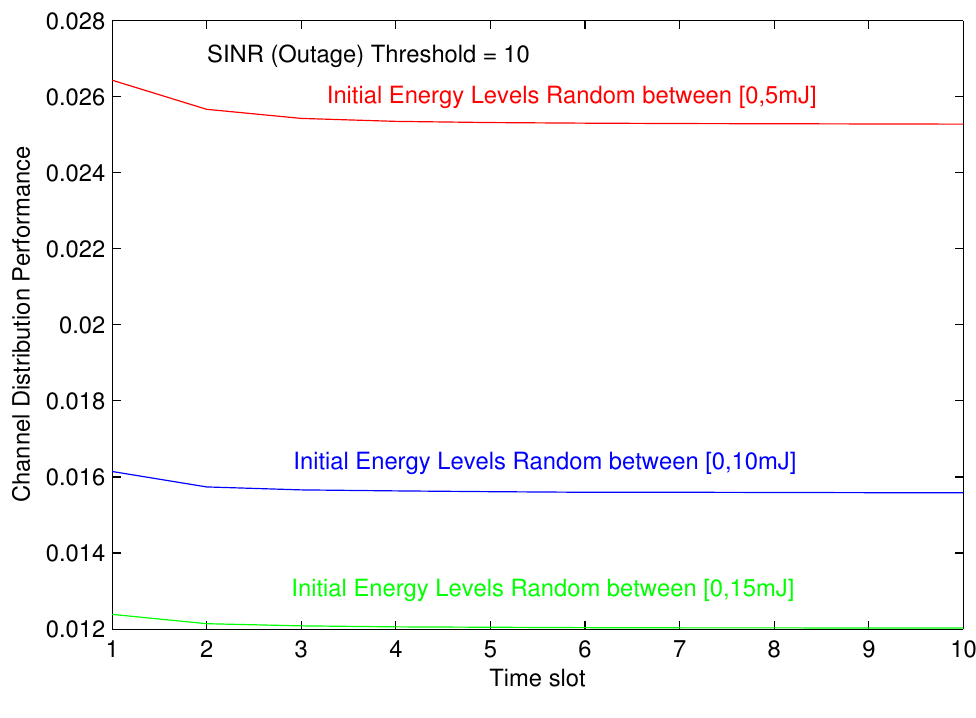
Figure 11. ChDistFairness against time slots for different initial energy levels of